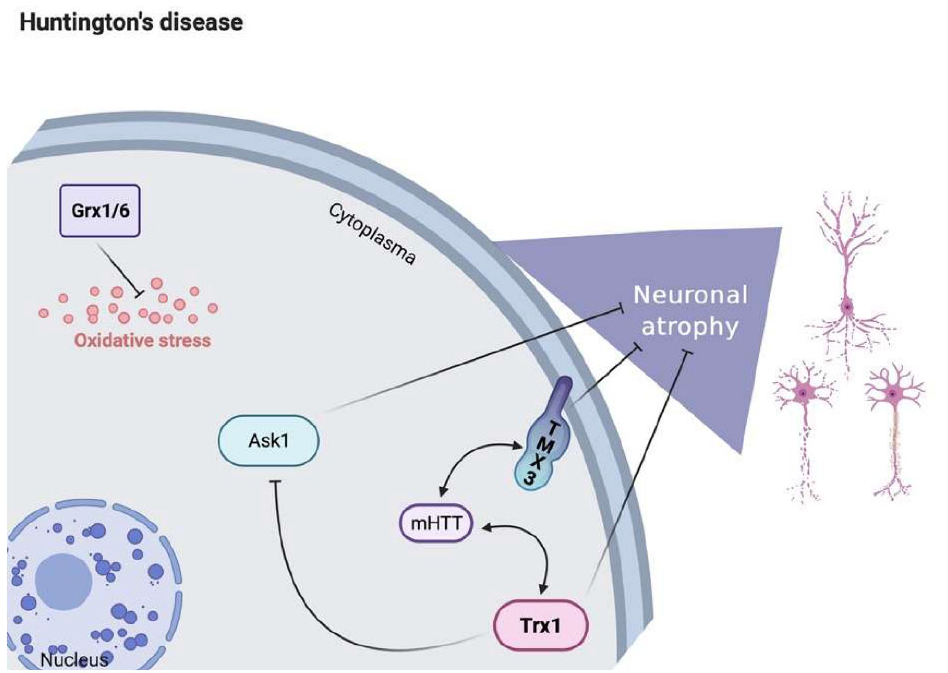
Figure 4. The role of Trx1 and Gpx in the pathophysiology of Huntington’s disease (HD). Trx1 and GPx participate in various biological pathways in relation to HD. The neuron protection activity of Trx1 is achieved via a decrease of both mHTT and ASK1. Moreover, high expression levels of GPx1/6 also play a crucial role against oxidative stress in HD patients. Trx: thioredoxin reductase; TMX3: thioredoxin-related transmembrane protein 3; ASK1: apoptosis signal-regulating kinase 1; GPx: glutathione peroxidase; mHTT: mutant Huntington protein.